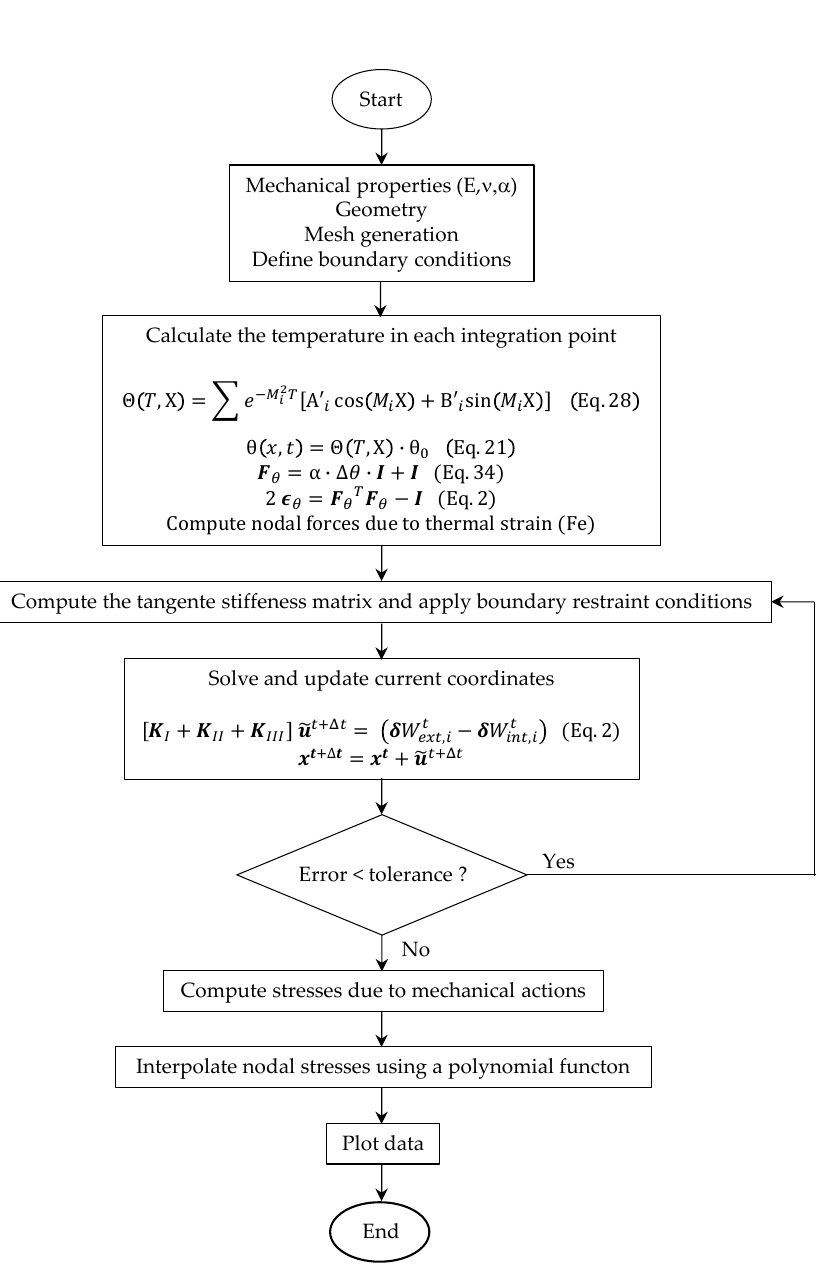
Figure A1. Procedure used to evaluate thermal stresses in marble slabs.